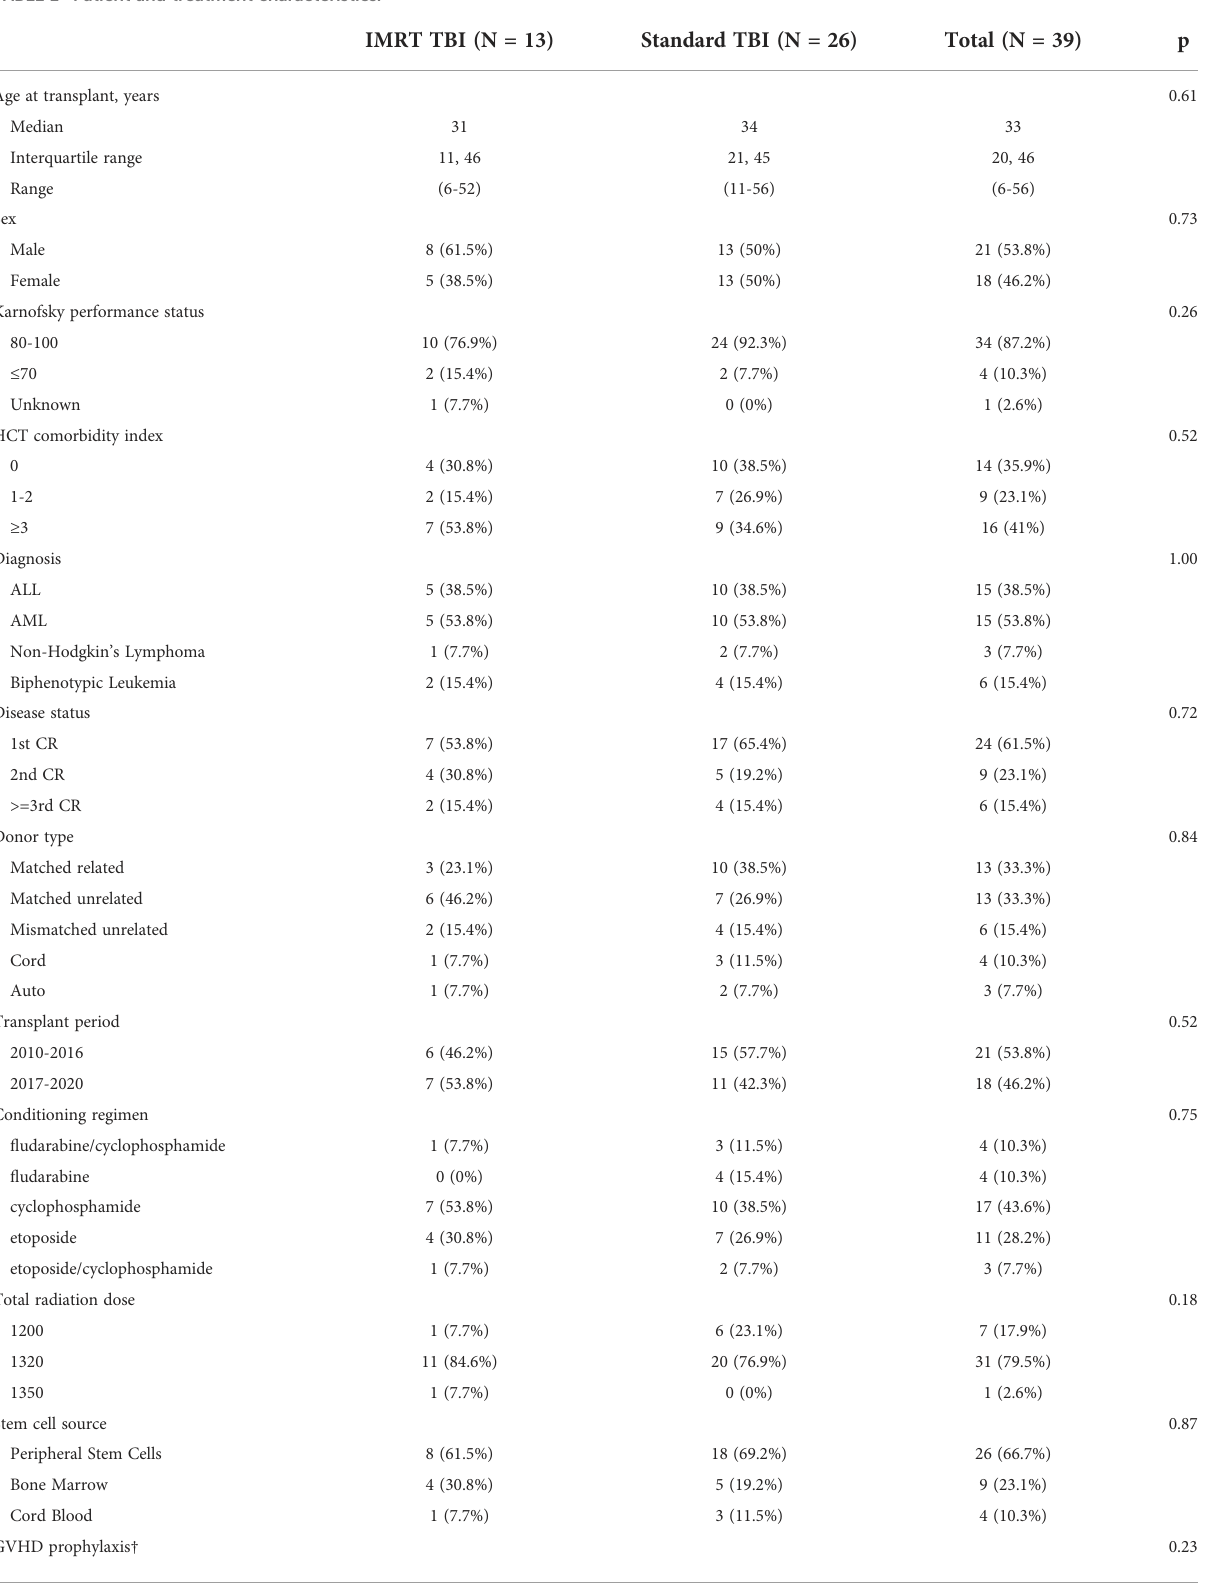
TABLE 1 Patient and treatment